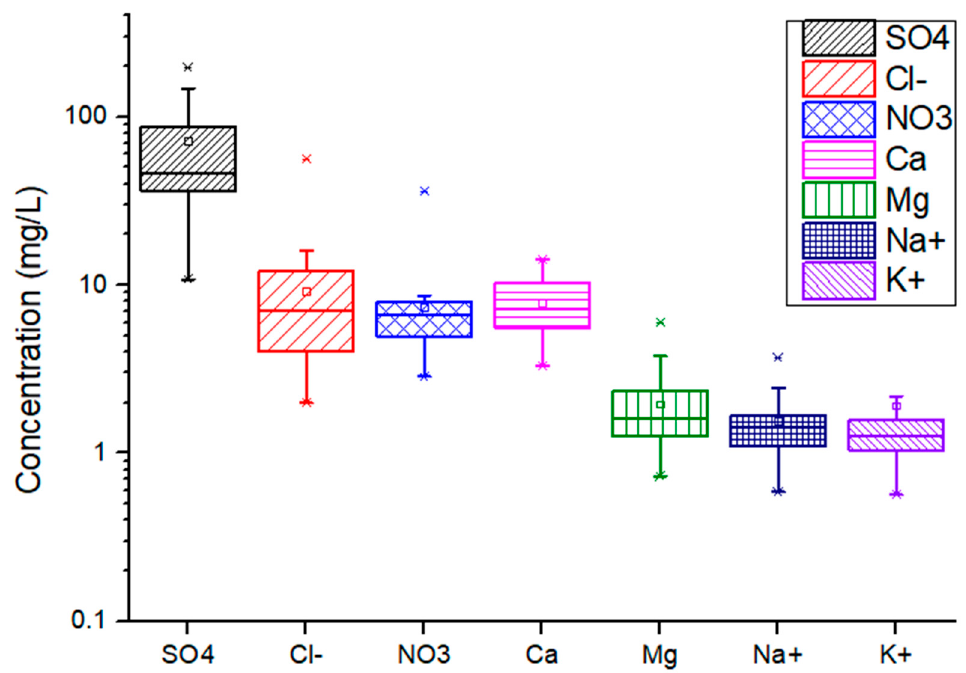
Figure 3. Box plot showing ions in fog water from Dec. 2020 to Feb. 2021. Box in the figure shows the interquartile range, the star shows outliers, the line shows the median, and the small square box is the mean (n = 26 samples).